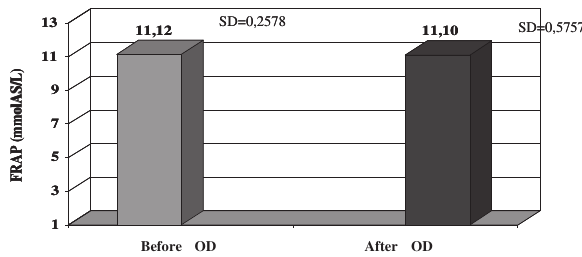
Figure 6. Osmotic distillation induced changes in total antioxidant capacity of ‘Oblachinska’sour cherry fruit juice